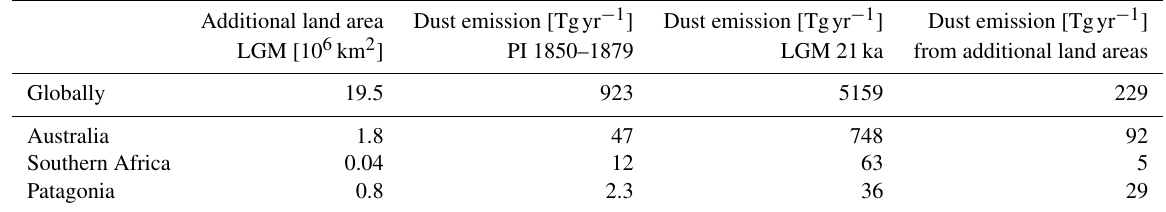
Table 4. Additional land areas in Australia, southern Africa, Patagonia, and globally during the LGM compared to the PI due to the lower sea level in 10 6 km 2 and the dust emissions from those extended drylands (in Tgyr − 1